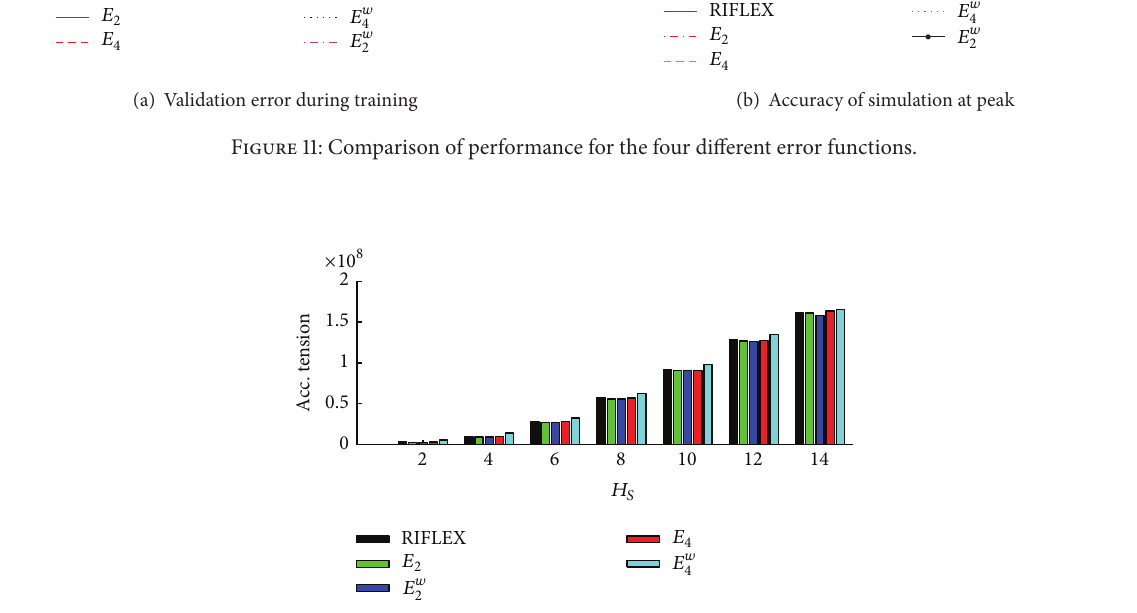
Figure 12: Accumulated stress for each sea state—calculated using rain flow